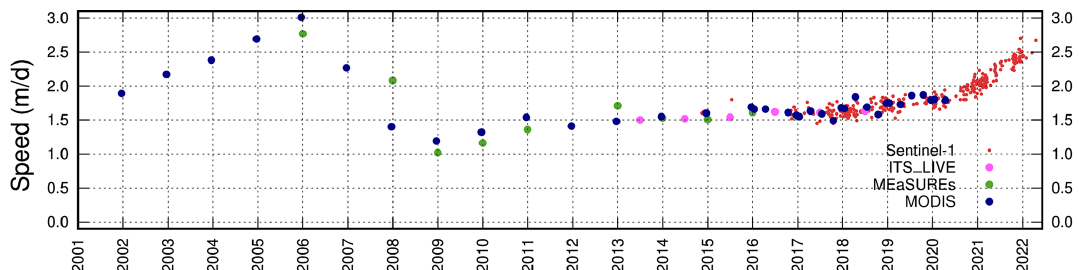
Figure 6. Velocity evolution at a point in the centre of TEIS from MODIS (blue dots; Alley et al., 2021), ITS_LIVE (pink), MEaSUREs (green) and Sentinel-1 (small red) showing the 2002–2006 acceleration, the 2006–2009 slowdown, the 2009–2020 modest acceleration and recent rapid acceleration as the shelf crossed the fracture transition. Location of velocity data is shown by the magenta circle in Fig. 4.